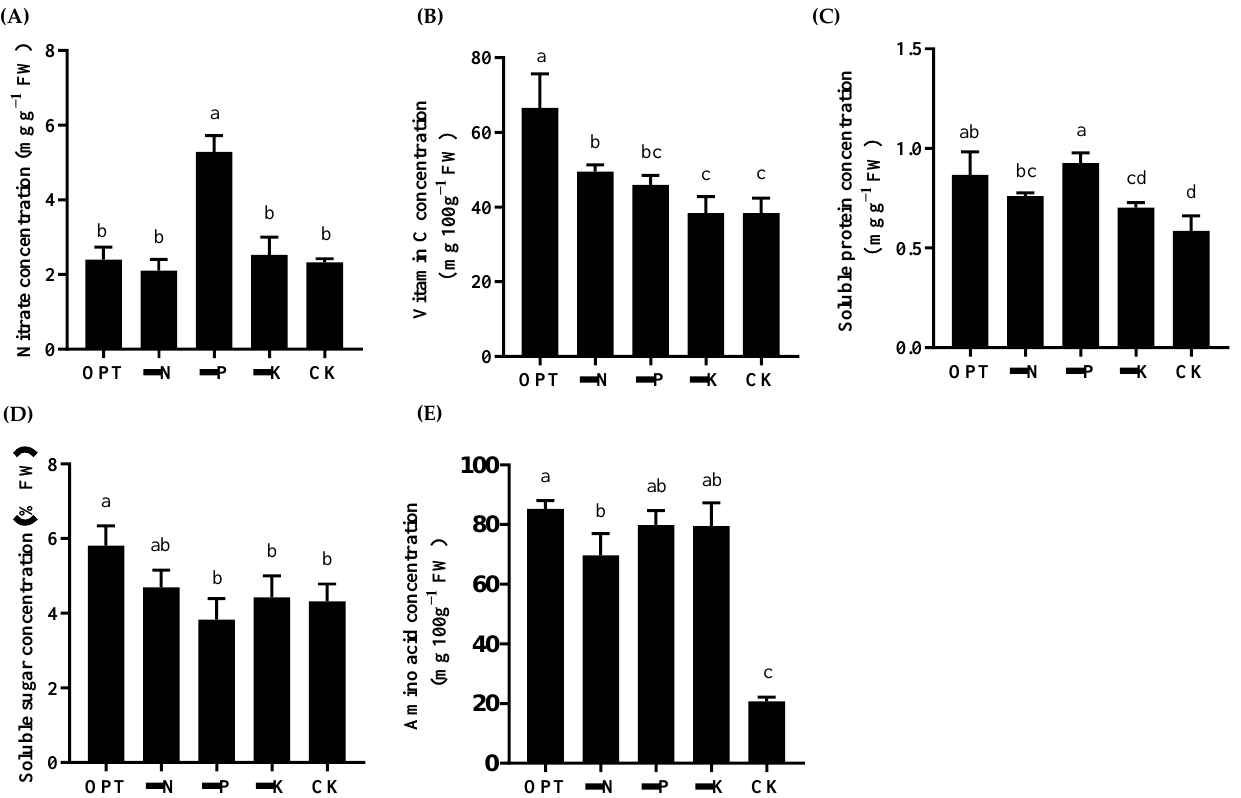
Figure 6. Effects of N, P, and K balanced fertilization on quality of lettuce. ( A ) Nitrate concentration; ( B ) Vitamin C concentration; ( C ) Soluble protein concentration; ( D ) Soluble sugar concentration; and ( E ) Amino acid concentration. Different letters indicate the distinct differences at p < 0.05.